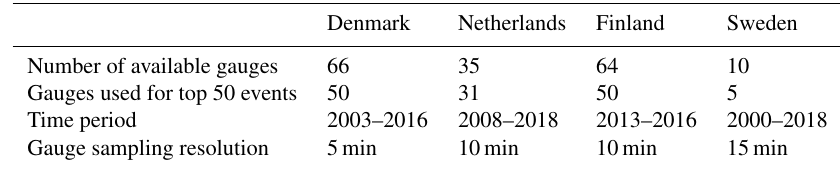
Table 1. Rain gauge datasets used to determine the top 50 rainfall events for each country. The time periods were chosen based on radar data